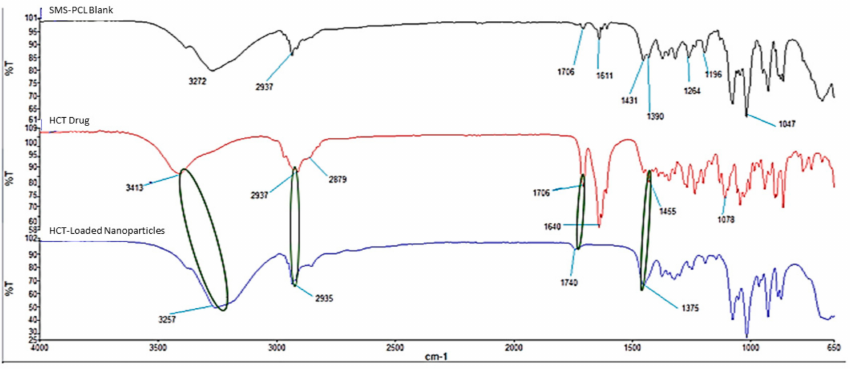
Figure 4. FTIR Spectra of the SMS-PCL blank polymers, HCT drug (pure), and HCT-loaded